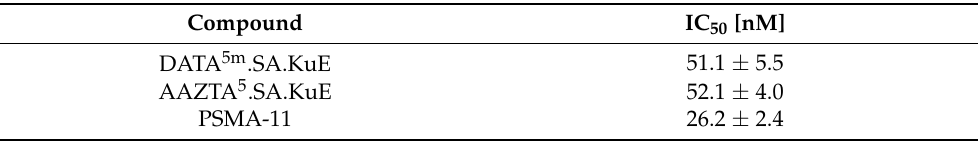
Table 1. IC 50 values of the investigated compounds. Data represented as mean ± SD (n =